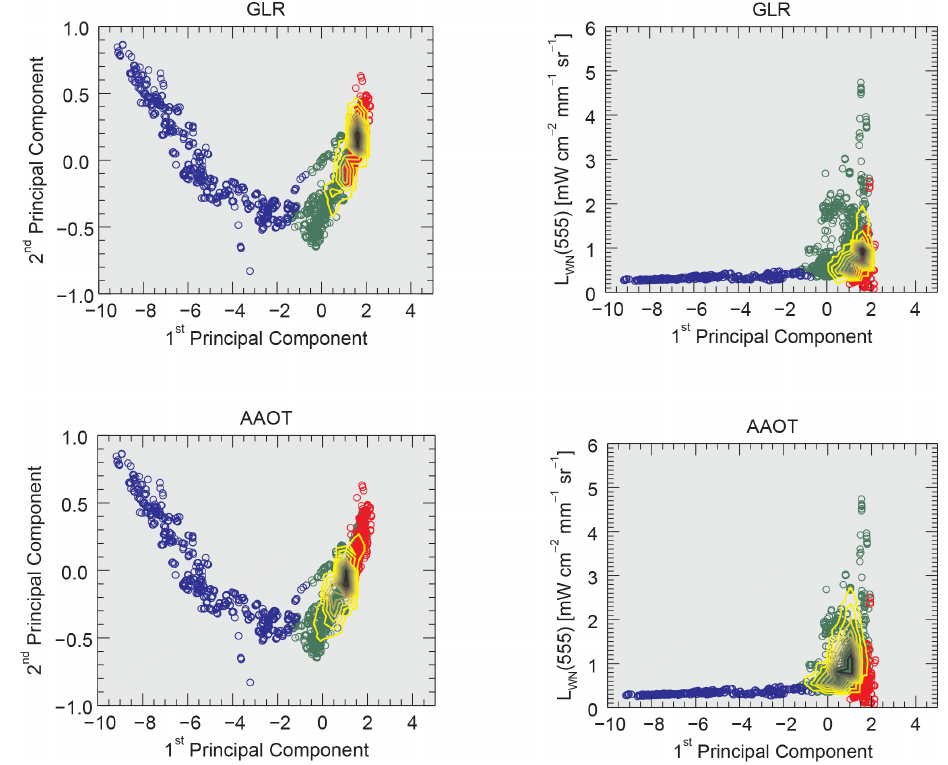
Figure 3. Maps of AERONET-OC L WN spectra from GLR (upper panels) and AAOT (lower panels) with the first two components of PCA applied to L WN (λ)/L WN (555) (left panels) and L WN (555) versus the first PCA component (right panels). While the isolines refer to the density distribution of AERONET-OC L WN from GLR or AAOT sites (indicating 10% increments from light yellow to black), the circles refer to different water types (see Zibordi et al., 2011): blue for oligotrophic and mesotrophic Chl a -dominated waters; red for yellow- substance-dominated waters; and green for a number of optically complex waters likely expected to be moderately sediment